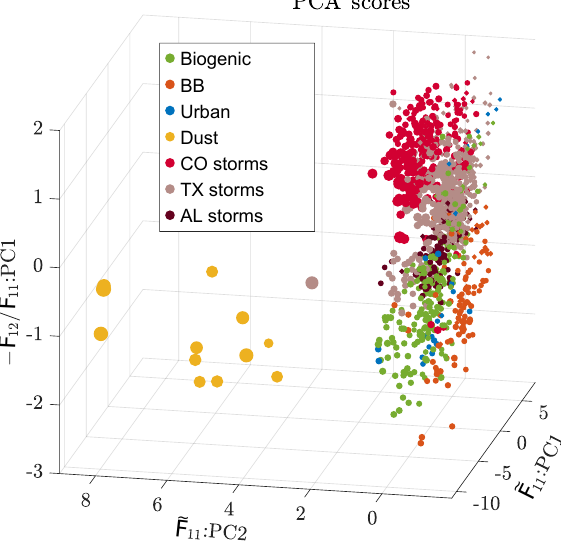
Figure 6. The resulting PCA scores, color-coded by type, as a func- tion of the first two e F 11 principal component scores and the first − F 12 /F 11 score. The points are sized according to the effective ra- dius of the